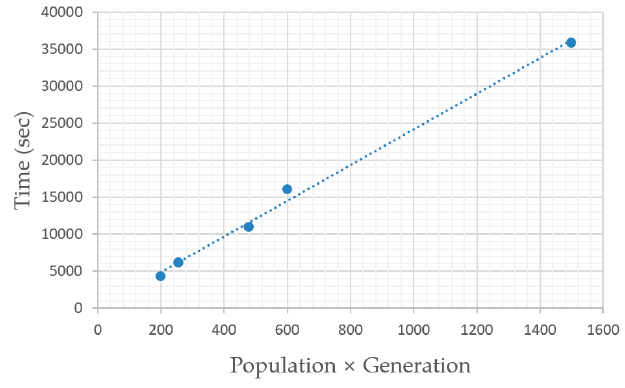
Figure 18. GA problem size and time taken for optimization.